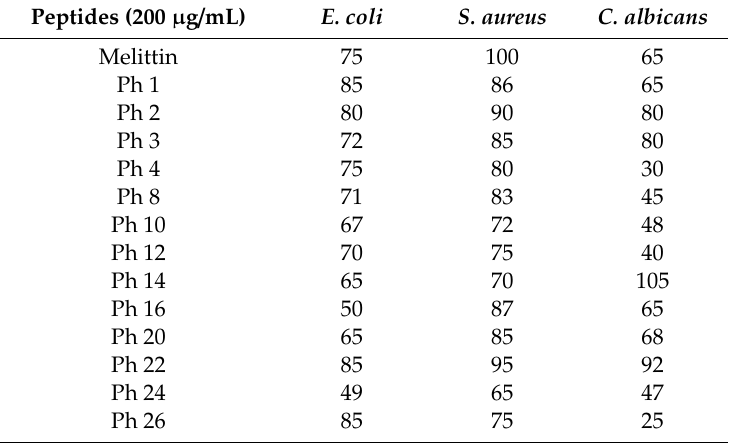
Table 4. Antimicrobial activities of P. hilaris peptides.